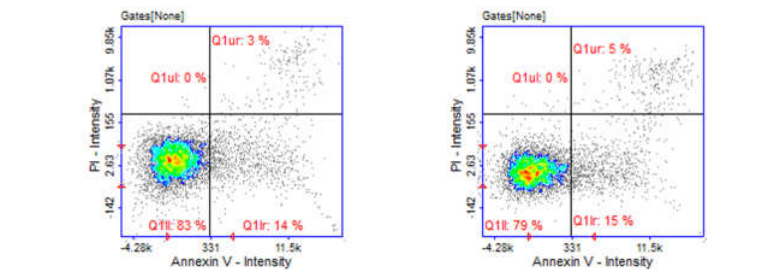
Figure 4. ( A ) Detection of cell apoptosis in H9c2 cells by image cytometry. Cells were treated for 48 h with 2 µM of DOX and 125 µg/mL of CAS H 2 O or 125 µg/mL of CAS MeOH, or a combination (DOX + CAS MeOH/DOX + CAS H 2 O). Values obtained from three independent experiments are presented as means ± SDs. ( B ) Representative histograms (Q1II: live cells; Q1Ir: early apoptotic cells; Q1ur: late apoptotic cells; Q1uI: necrotic cells). DOX: doxorubicin; CAS MeOH: Centaurea